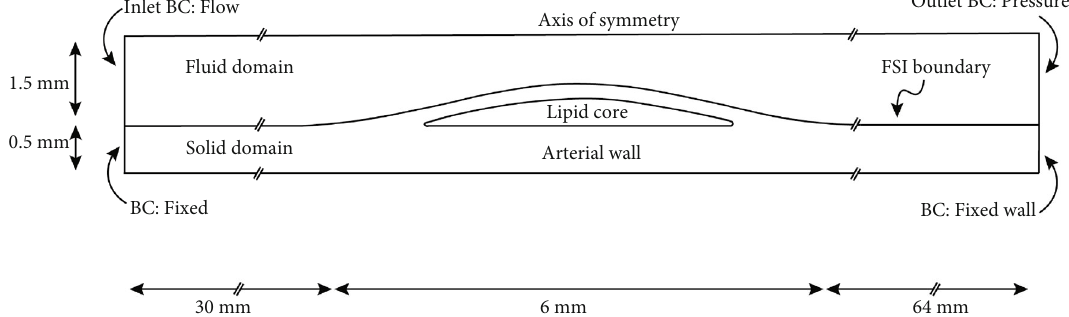
Figure 2: Complete fl uid-structure model with the respective boundary conditions and